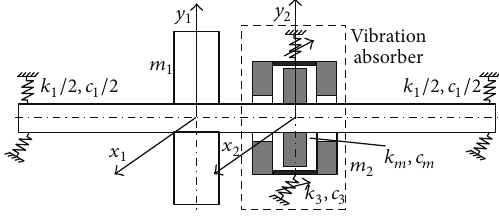
Figure 6: Dynamic model of the rotor-absorber